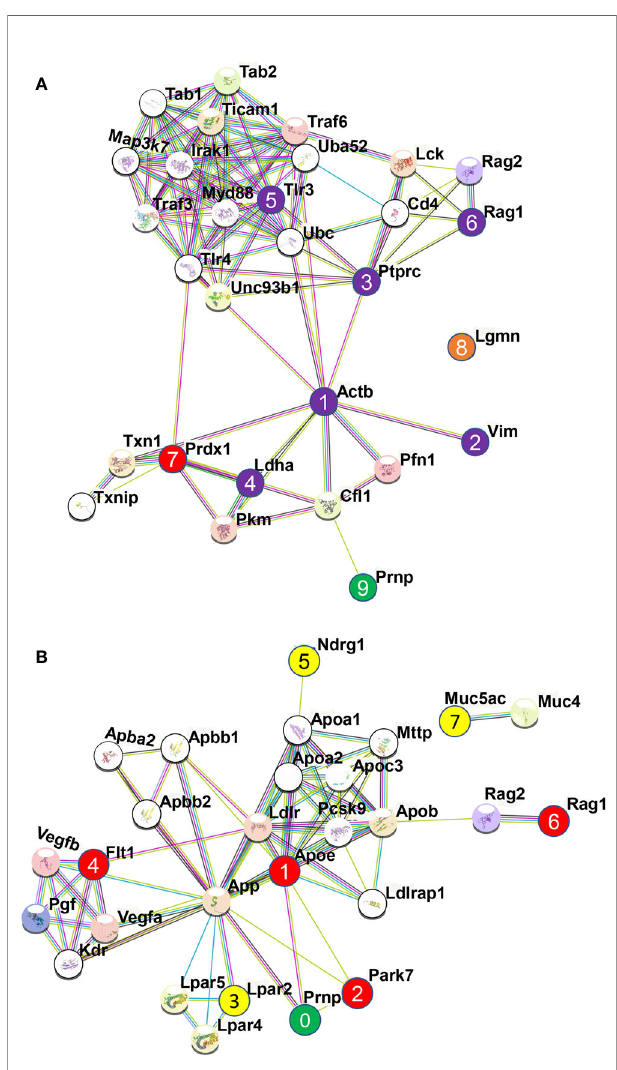
FIGURE 5 | Protein-protein interaction analysis among the identi fi ed allergenic genes following direct microglial treatment (DMT) with anti-PrP antibodies in cell line and mouse primary neuron. The analysis was performed using STRING v11.0 server. The Mus Musculus database was used as the host organism for characterising the protein interactions. (A) Protein-protein interaction among the identi fi ed 8 allergenic genes following direct microglial treatment (DMT) with anti-PrP antibodies in mouse neuroblastoma cell line. Herein, interaction among the allergenic proteins and with PrP C where the numbered purple circles (numbered 1, 2, 3, 4, 5, 6) and numbered red circle refer to allergenic-related proteins identi fi ed following DMT and shown here to be part of the same interactome. The red circle (numbered 7) was shown to be downregulated and the orange circle (numbered 8) is not part of the interactome with other allergenic-related proteins. Finally, the green circle (numbered 9) represents the prion protein, PrP C . (B) Protein-protein interaction among the 7 identi fi ed allergenic genes following direct microglial treatment (DMT) with anti-PrP antibodies in mouse primary neuron (MPN). Herein, Interaction among the allergenic proteins (numbered 1, 2, 3, 4, 5, 6 & 7) and with PrP C (numbered 0) following direct microglia treatment where red and yellow color indicate the downregulated and upregulated genes, respectively and green color represents the cellular prion protein PrP C